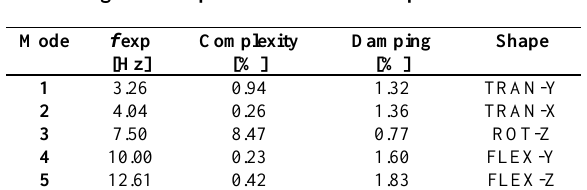
Figure 6. Experimental modal shapes recorded